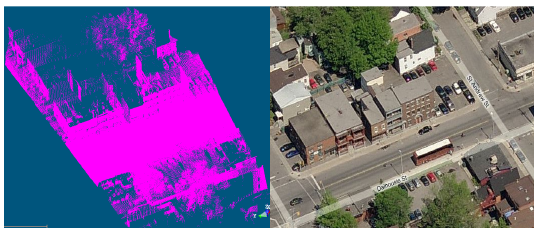
Figure 3. Dalhousie St dataset. Left: Input point cloud. Right: www.bing.com.